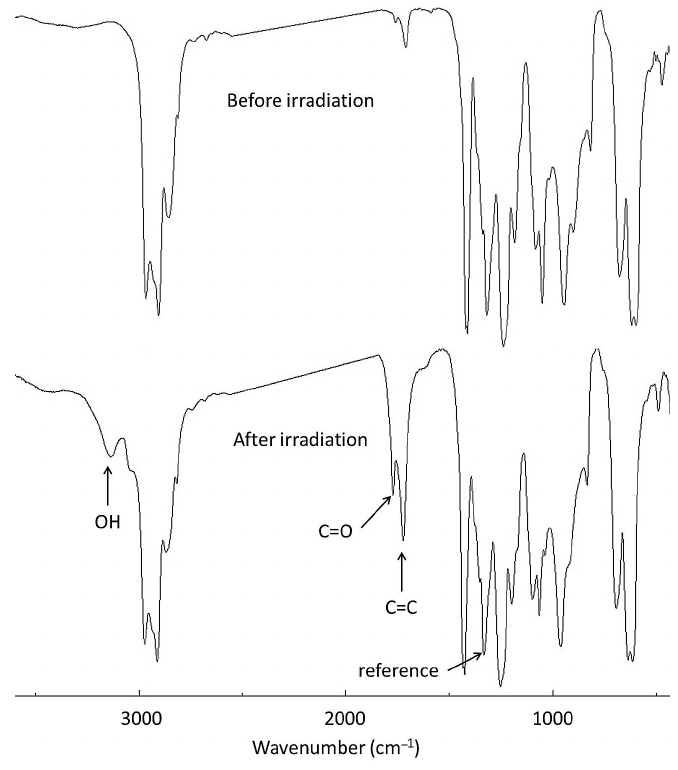
Figure 3. FTIR spectrum of PVC film before and after irradiation (300